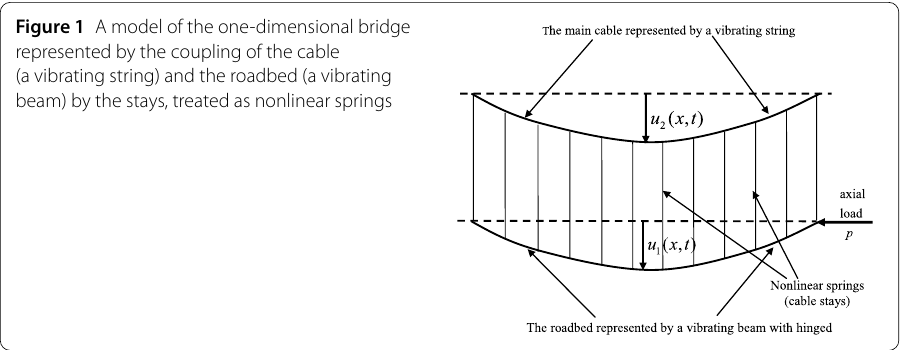
Figure 1 A model of the one-dimensional bridge represented by the coupling of the cable (a vibrating string) and the roadbed (a vibrating beam) by the stays, treated as nonlinear